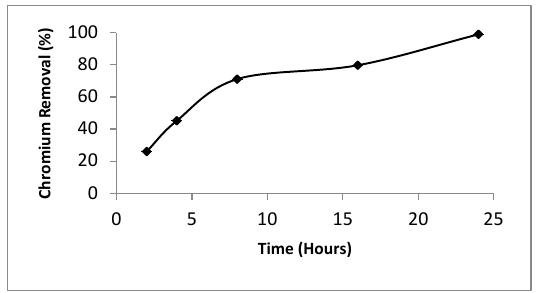
Figure 1. The impact of contact time (hours) impact on the Cr removal ability of Staphylococcus aureus K1